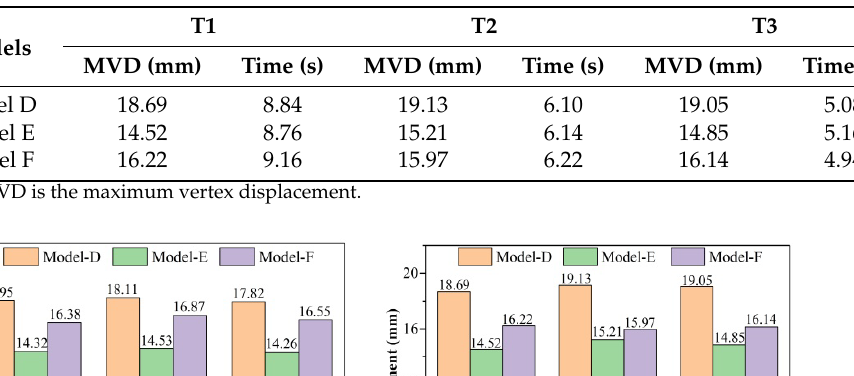
Table 11. The maximum vertex displacement in the Y-direction.